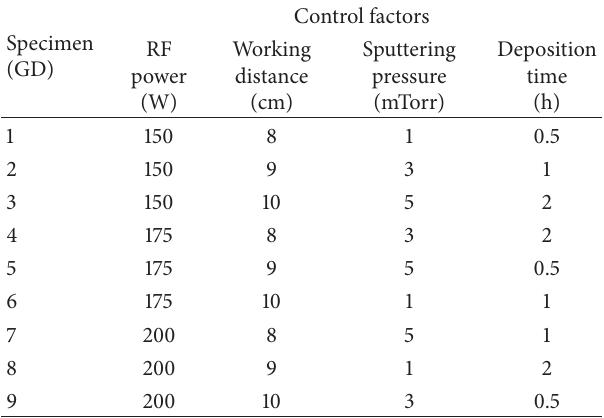
Table 2: Design of experiments (DOE) according to L onal array.